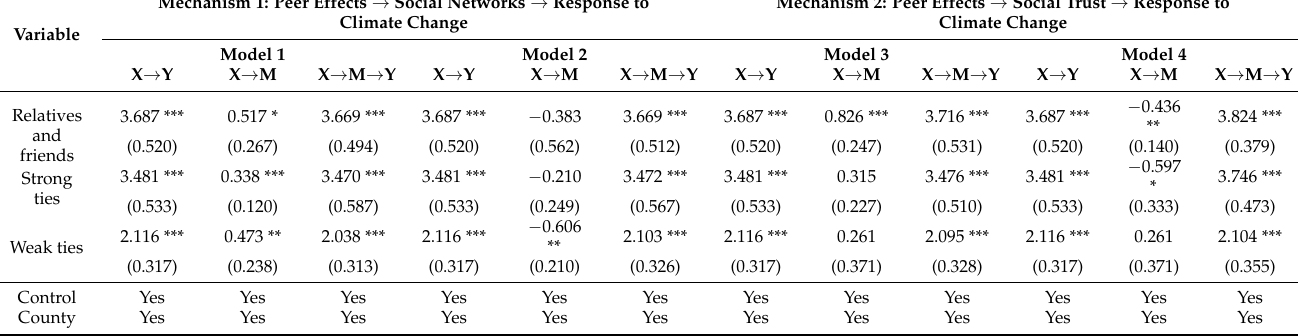
Table 6. Mechanism